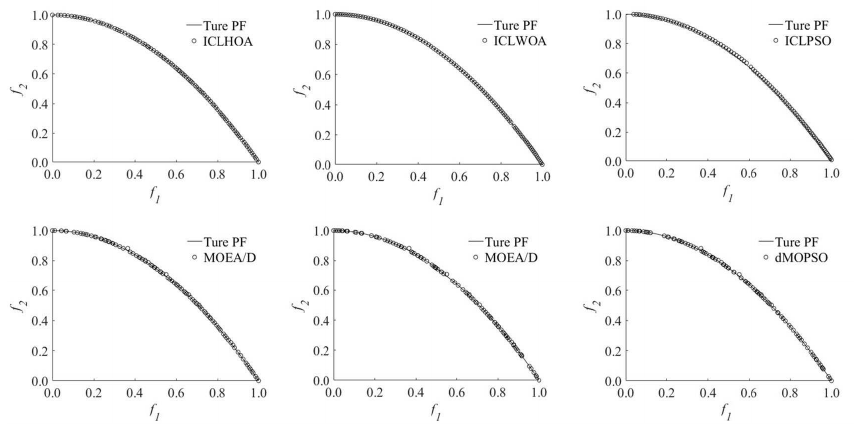
Figure 10. ZDT2 PF of each optimization algorithm.